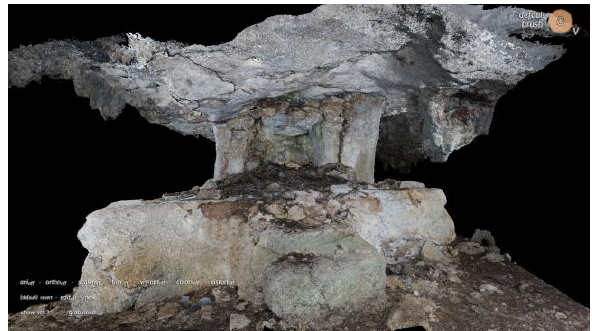
Figure 6. Point cloud (via SfM photogrammetry) of Shrine X-1.